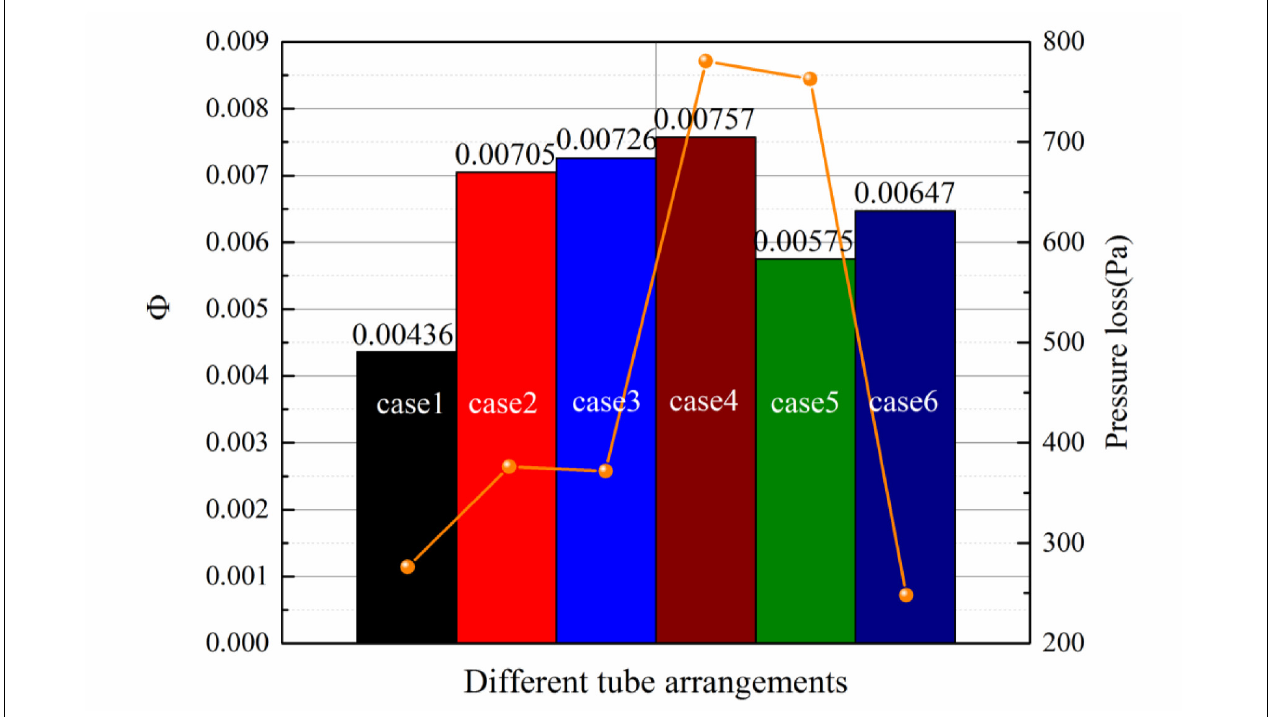
FIGURE 2 | The flow distribution cofficient and the pressure loss for different tube